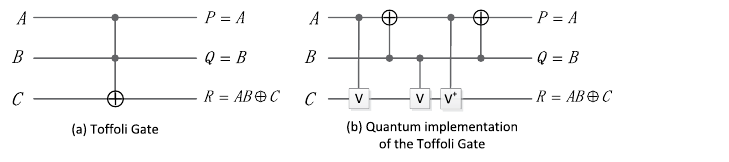
Figure 6. The CNOT gate.